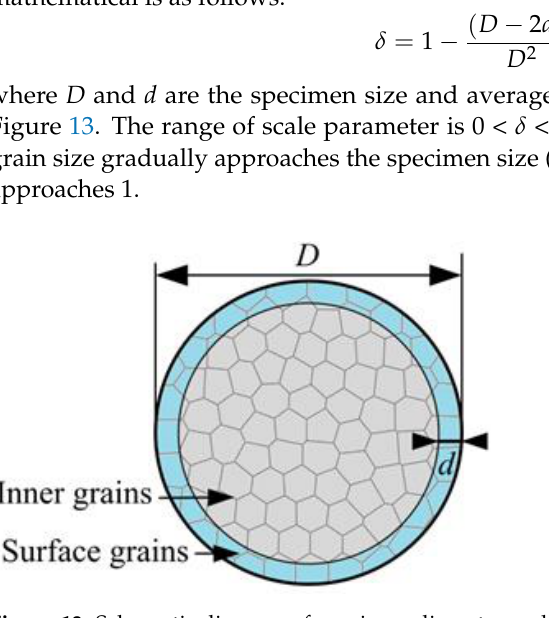
Table 2. Grain sizes and the scale parameters in the micro compression simulation process. Grain size d/ μm